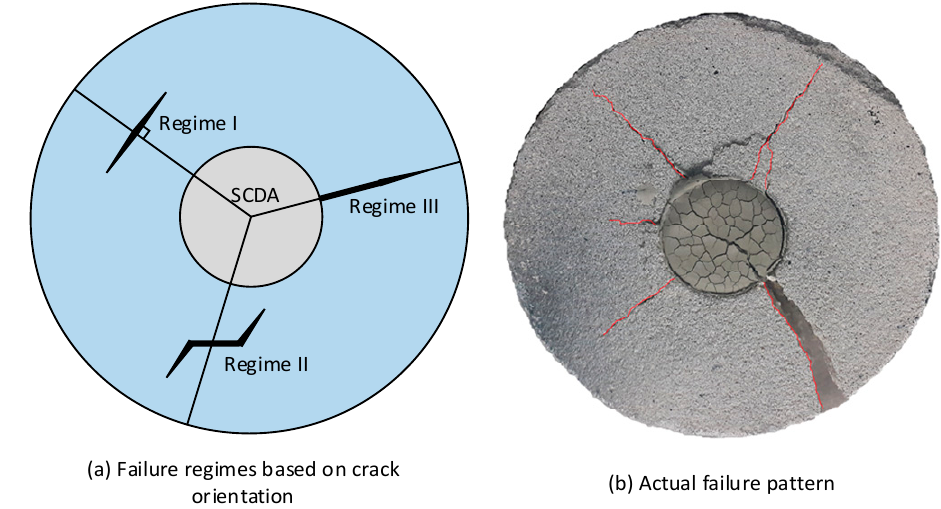
Figure 15. Failure regimes in rock fracturing using SCDA: ( a ) Possible failure regimes due to fracture orientation; ( b ) Observed fracture pattern from SCDA charging.